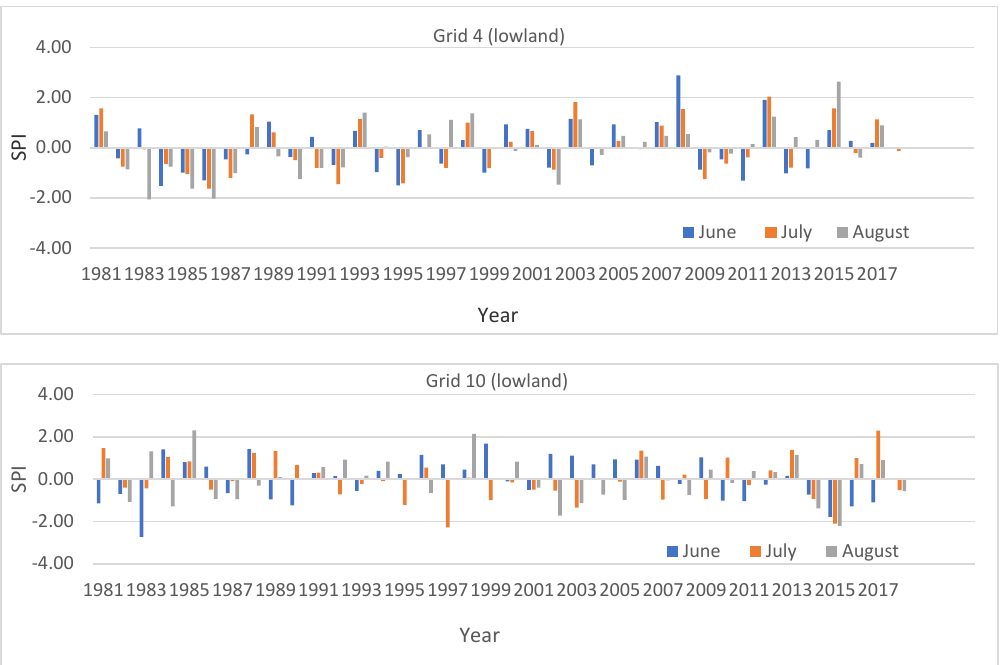
Figure 5. Monthly SPI in the selected places (grids) over the elevation zones of the Upper Blue Nile basin. Table 5. SPI value in the elevation zones of UBN from 2014 to 2018 in June and July. Given ID